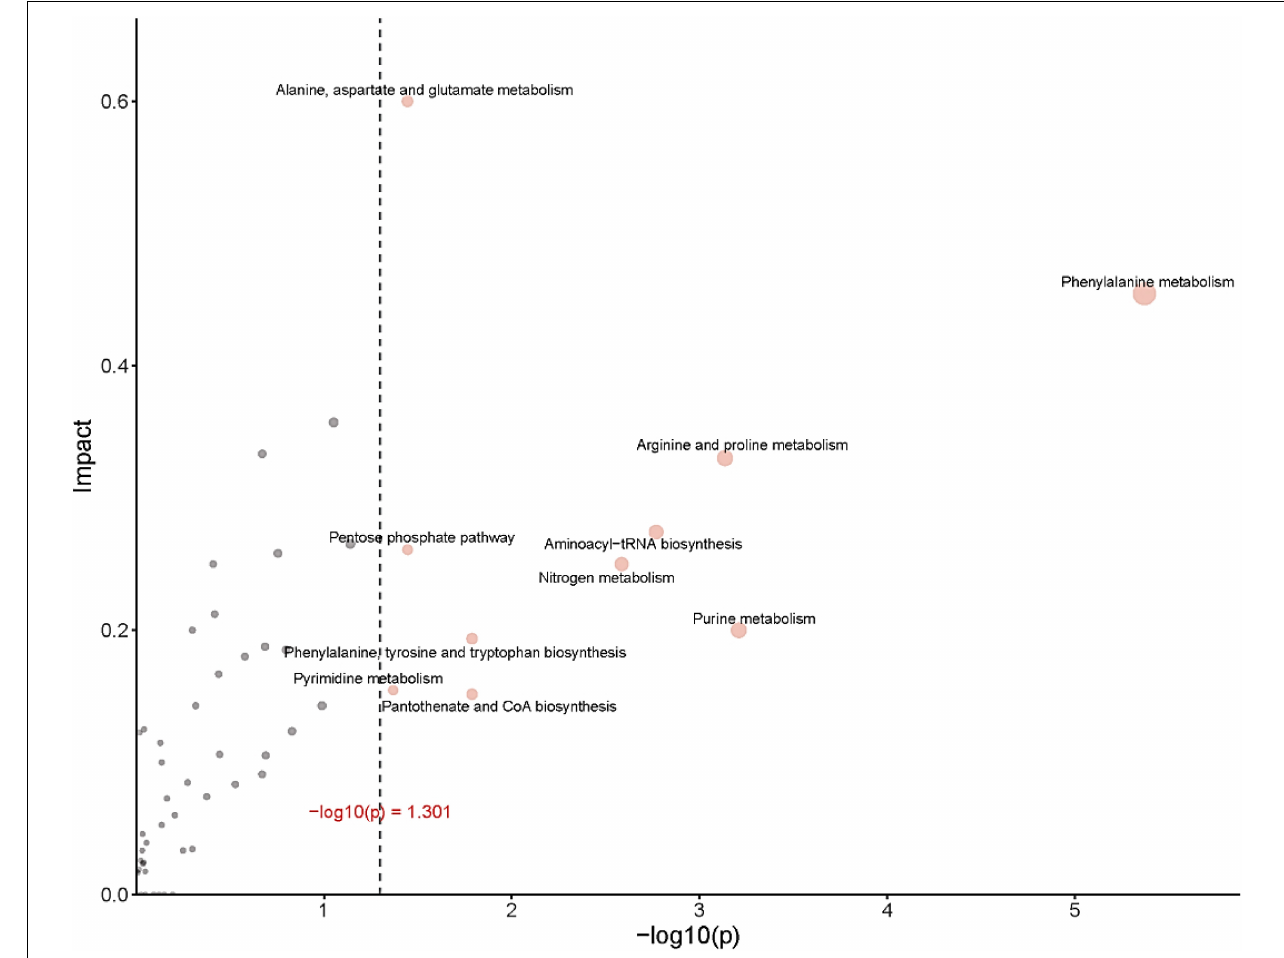
FIGURE 8 | ORA (enrichment analysis) and topological analysis diagram. (Horizontal coordinates indicate the p -value for ORA analysis. The area indicates significant differences ( p < 0.05). The ordinate indicates topological analysis